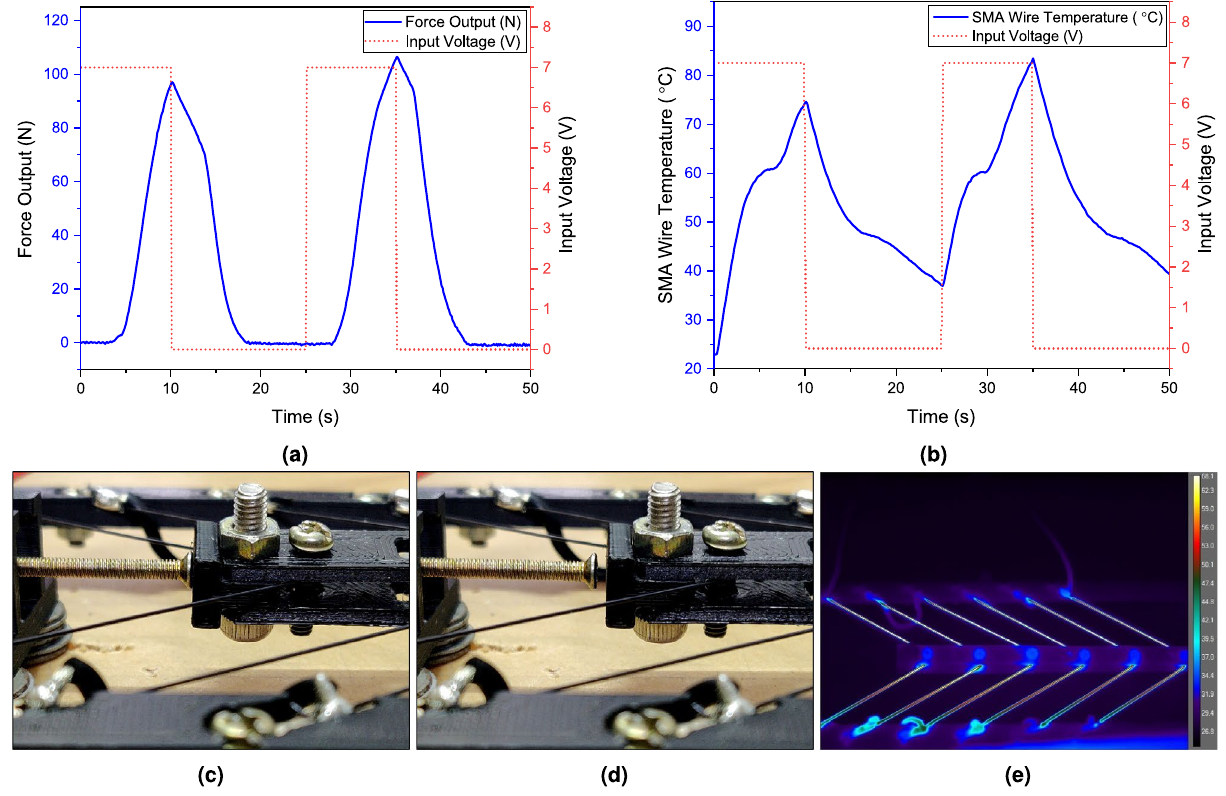
Figure 2. The plot depicts the experimental results for the temperature of the SMA wires as well as the force generated by the SMA-based bipennate actuator over two cycles. The input voltage was provided in two 10 s cycles (as shown by the red dots) with a 15 s cooling period between each cycle. The SMA wire used for the experimentation is the 0.51 mm diameter Flexinol wire from Dynalloy, Inc. ( a ) The graph depicts the experimental force obtained over the course of two cycles, ( c , d ) show two independent instances of the movable arm of actuator striking the PACEline CFT/5kN piezoelectric force transducer, ( b ) the graph depicts the maximum temperature across the entire length of the SMA wire during the two cycles, and ( e ) shows the snapshot of the temperature across the SMA wires obtained from the LWIR camera using the FLIR ResearchIR software. The geometric parameters considered for the experiment can be referred from Table